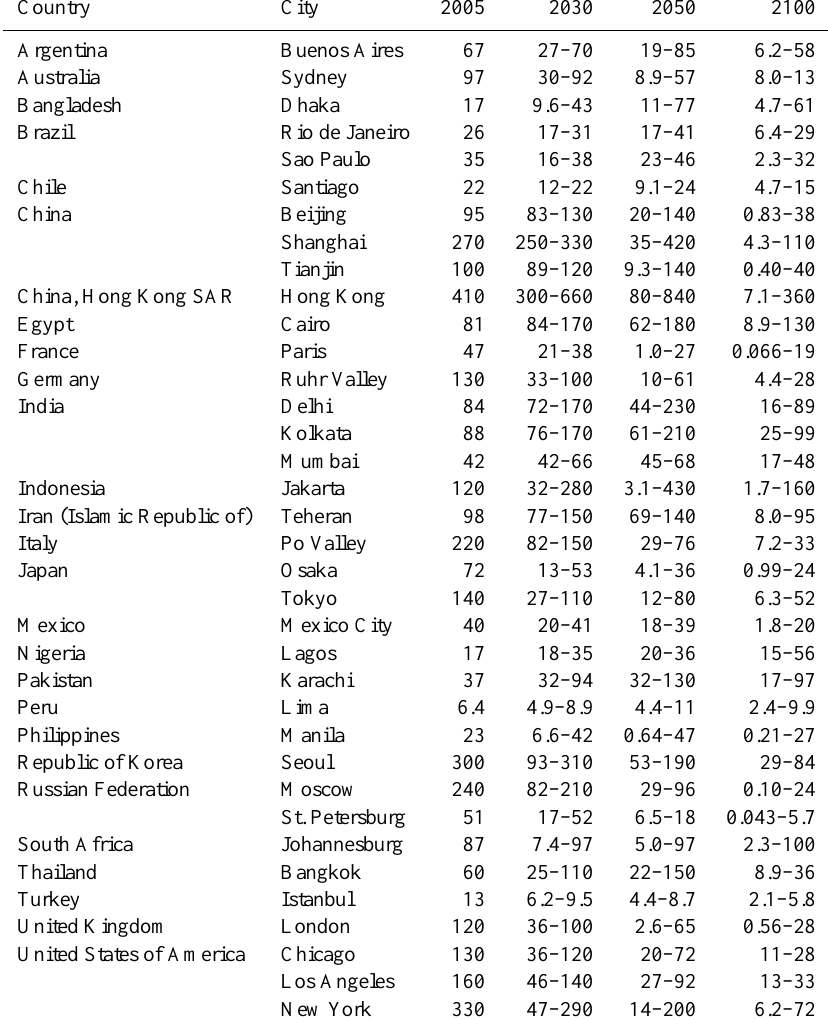
Table 1. Megacities considered in this study, along with their emissions of NO (Ggyr − 1 ) from the emissions scenarios used in this study. Emissions for 2005 are from RCP-8.5, while all future years show the range of emissions from all four RCP